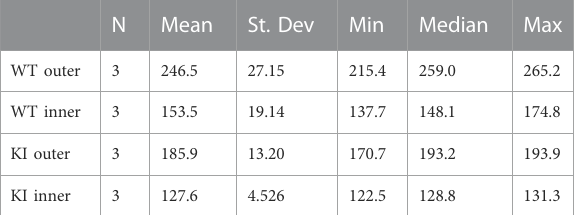
TABLE 1 Microhardness values (HV) of 1-month-old 1st